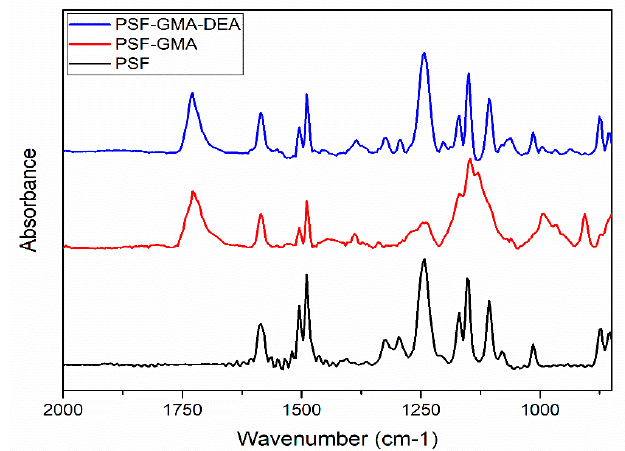
Figure 1. FTIR spectra of PSf base membrane (black), after modification with glycidyl methacrylate (GMA) (red), and further modification with diethylamine (DEA) (blue) to form PSf-GMA-DEA membrane.